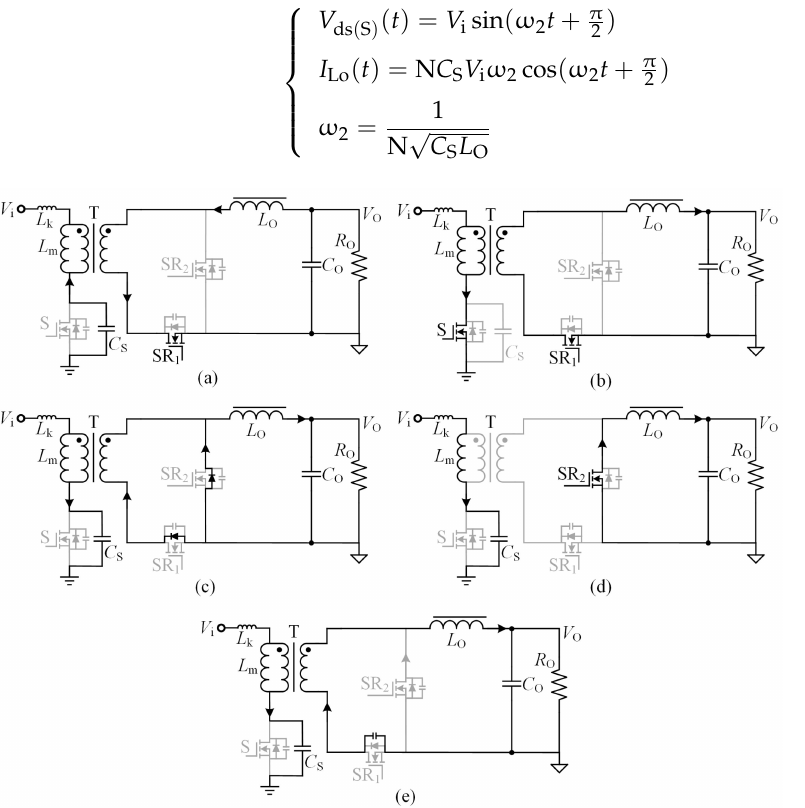
Figure 3. Equivalent circuits of each mode. ( a ) Mode 1 ( t 0 – t 1 ); ( b ) mode 2 ( t 1 – t 2 ); ( c ) mode 3 ( t 2 – t 3 ); ( d ) mode 4 ( t 3 – t 4 ); ( e ) mode 5 ( t 4 – t 0